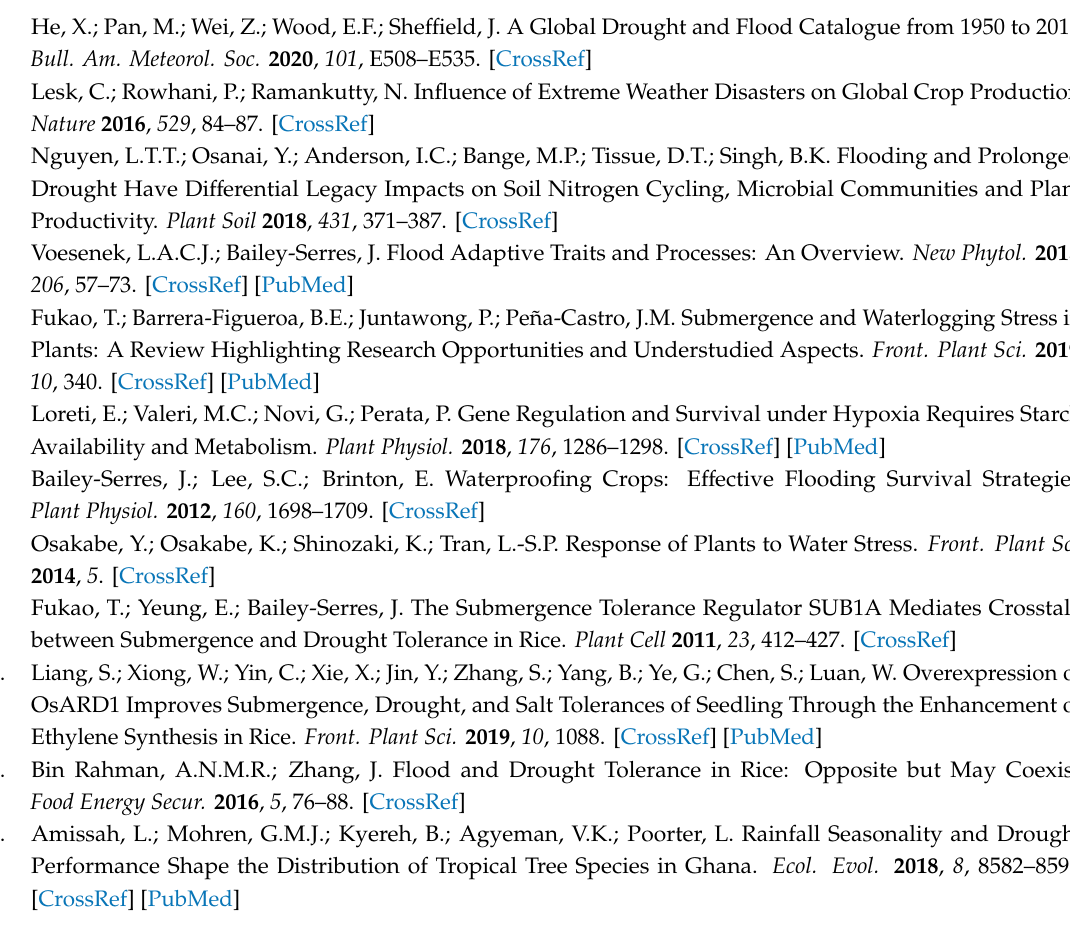
Figure S1: PHRED score distribution of small RNA reads in maize and teosinte libraries; Figure S2: Size distribution of small RNA reads in maize and teosinte libraries; Table S1: Known miRNA sequences expressed in maize and teosinte libraries; Table S2: Grouped sequences of known microRNAs expressed in maize and teosinte libraries; Table S3: Sequence variants of microRNAs expressed in maize and teosinte libraries; Table S4: The most abundant reads that mapped to NADH dehydrogenase subunit 2 from the Zea mays organelle DNA; Table S5: The most abundant reads that mapped to the trnL-trnF intergenic spacer and tRNA-Phe (trnF) gene from the maize chloroplast; Table S6: List of predicted targets of submergence and drought-responsive miRNAs; Table S7: List of adapters and primers used in this